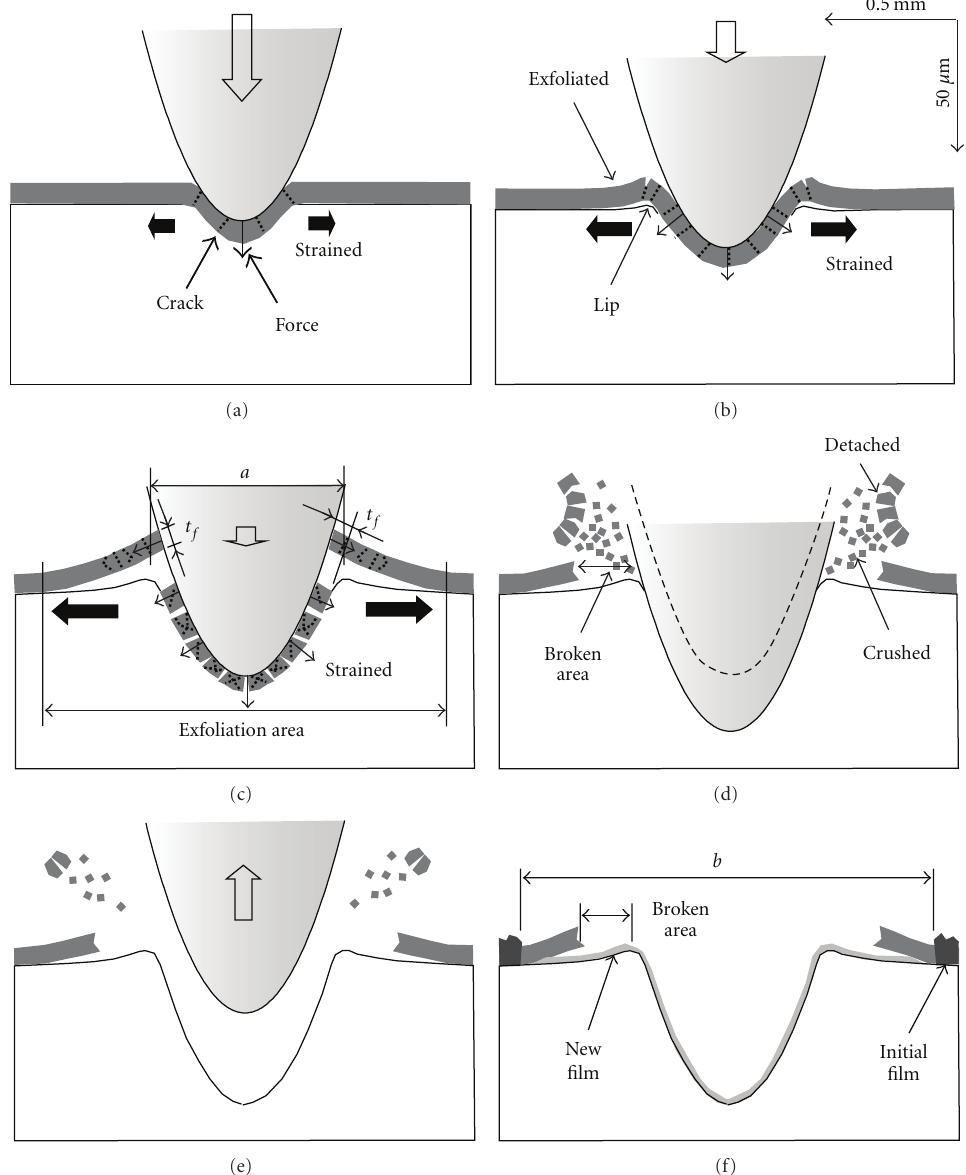
Figure 11: Exfoliation and fracture process of oxide films by the impact of a glass ball at a high-temperature environment.